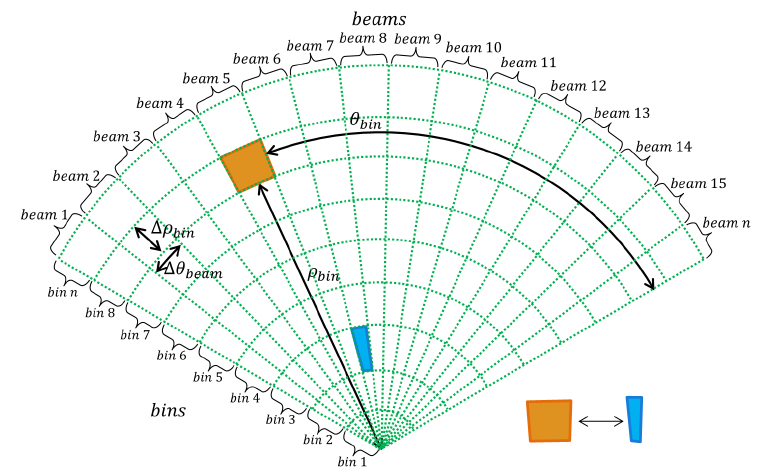
Figure 2. A representative scheme of image formation of an FLS. Each bin can be identified on the polar coordinate system ( θ bin , ρ bin ) and has an angular resolution ∆ θ beam and a range resolution ∆ ρ bin . For this reason, the most distant bins have a lower resolution than the nearest bins. This effect can be visualized on the blue and orange highlight